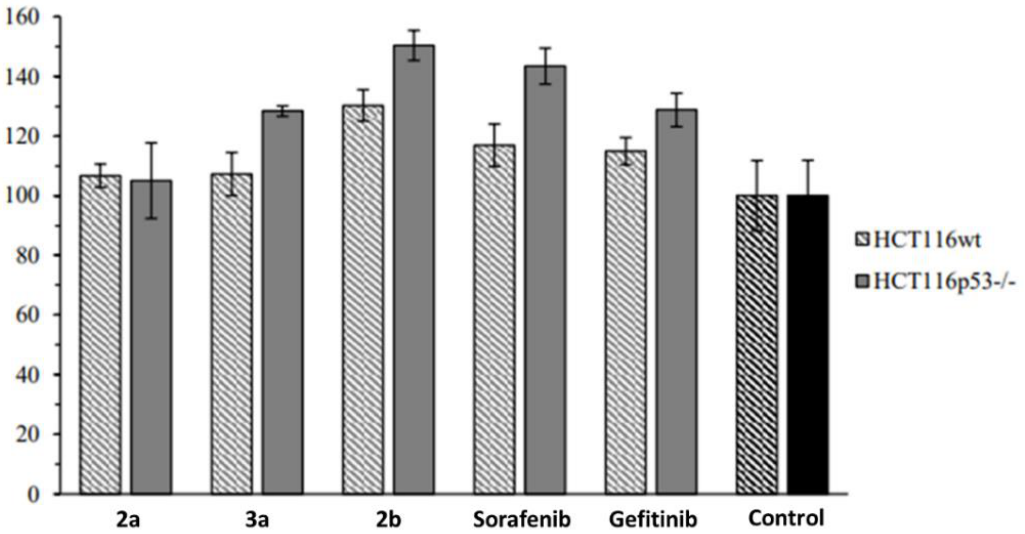
Figure 4. ROS formation by 2a , 2b and 3a (4 × IC 50 ) in HCT-116 wildtype and p53-knockout cells after 24 h. Sorafenib (4 × IC 50 ) and gefitinib (200 µ M for HCT-116 wildtype cells and 4 × IC 50 for p53-knockout cells) were used as positive controls. y-axis: Fluorescence in % with control set to 100%. n = 3 ± SD.